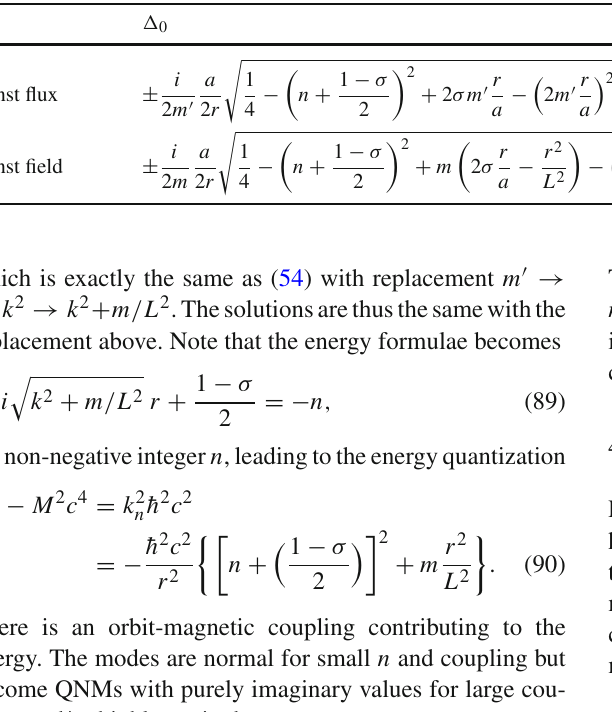
Table 4 The asymptotic parameter (cid:21) 0 , H at u = 0 , u H for Beltrami